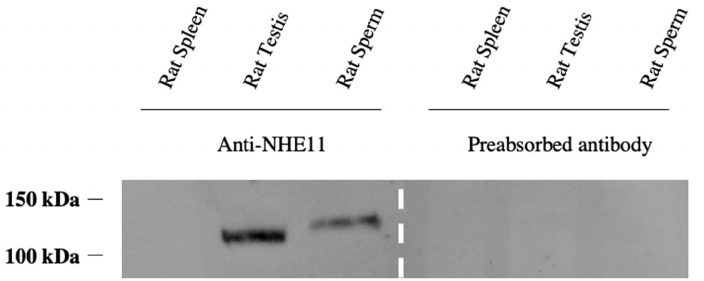
Figure 3. Characterization of the anti-NHE11 polyclonal antibody. Immunoblotting of rat tissue with our affinity-purified anti-NHE11 polyclonal antibody. The blot on the left of the dashed lines shows that this anti-NHE11 antibody recognizes a single band at the predicted size of ~130 kDa in rat testes and sperm, but not in rat spleens. The NHE11 immunoreactive band was not seen if the anti-NHE11 antibody was preabsorbed with the NHE11 antigenic peptide prior to probing the blot, demonstrating the specificity of this antibody. Based on the deduced amino acid sequence, the calculated size for rat NHE11 is 131.5 kDa.